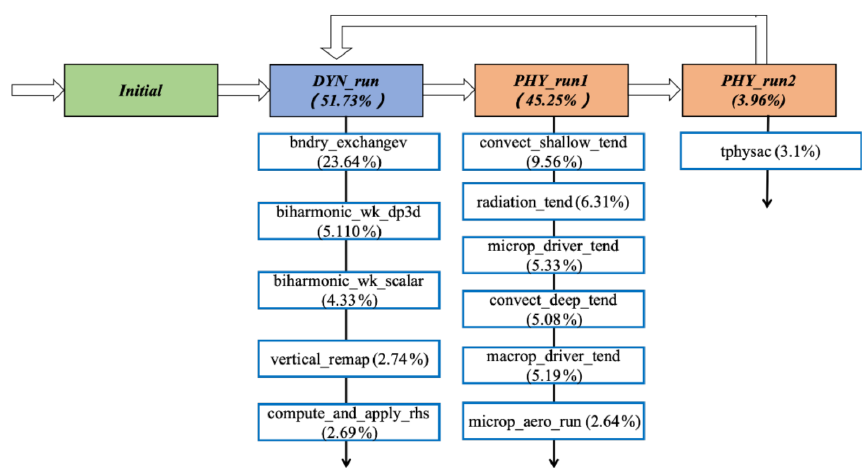
Figure 4. The major consumers of run time in the CAM5 model. The profiling is performed with a 25km CAM5 run using 29000 MPI processes.